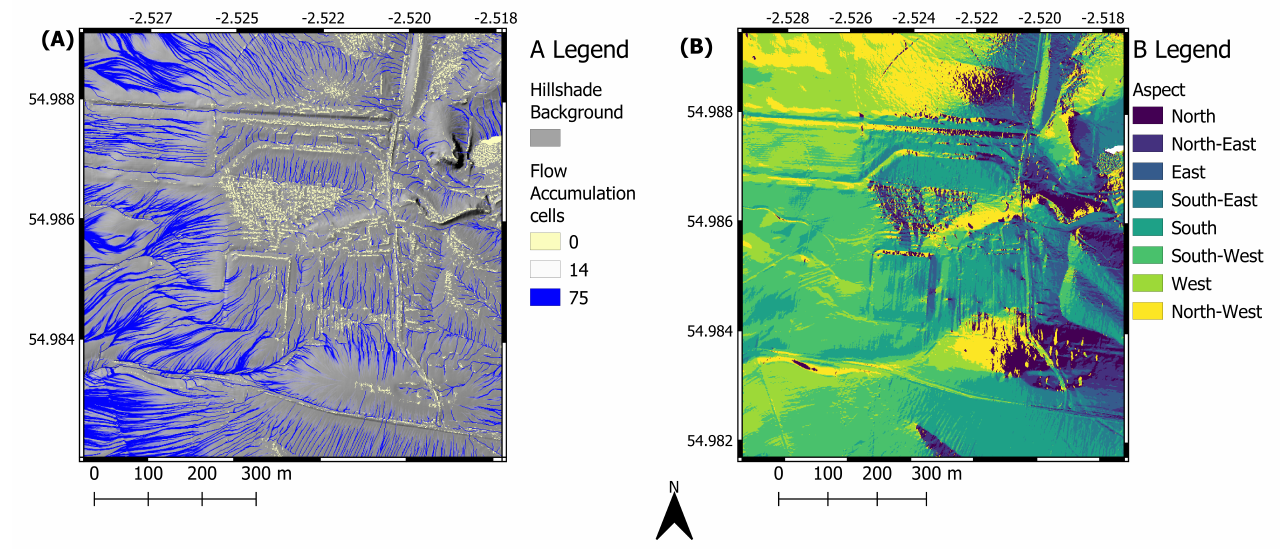
Figure 3. Flow accumulation diagram ( A ) for the site calculated from UK Environment Agency LiDAR DTM and the QGIS GRASS r.flow algorithm. Visualisation has been limited to cells which contain the accumulation of 75 other 1 m 2 cells, to highlight the main flow paths. Pit cells are also displayed, representing a high likelihood of ground saturation during rainfall. This is displayed on top of a hillshade map to enable visualization of the topography these flow paths are crossing. The Hill Aspect map ( B ) confirms flow direction by showing the direction of slope